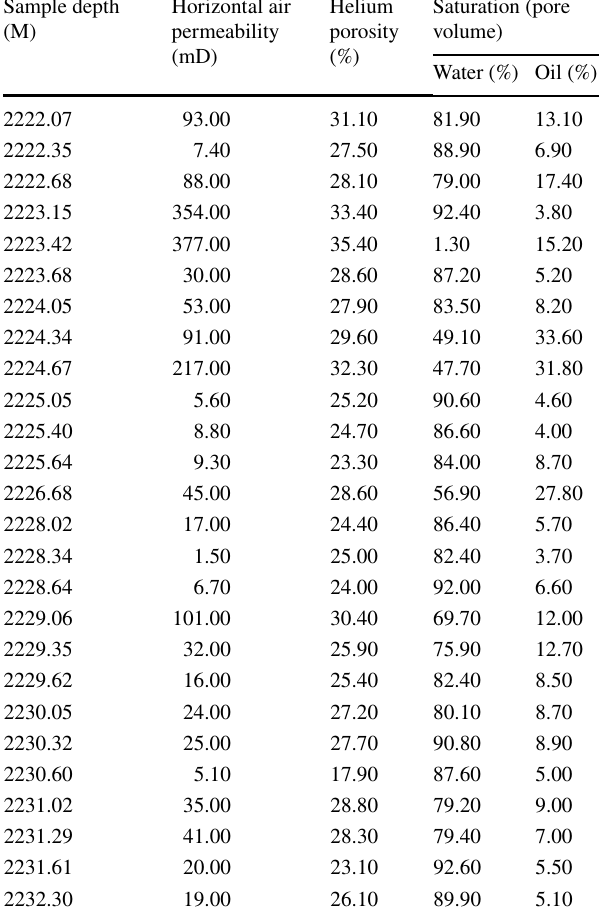
Table 1 Petrophysical data of PZ-2 well, Niger Delta